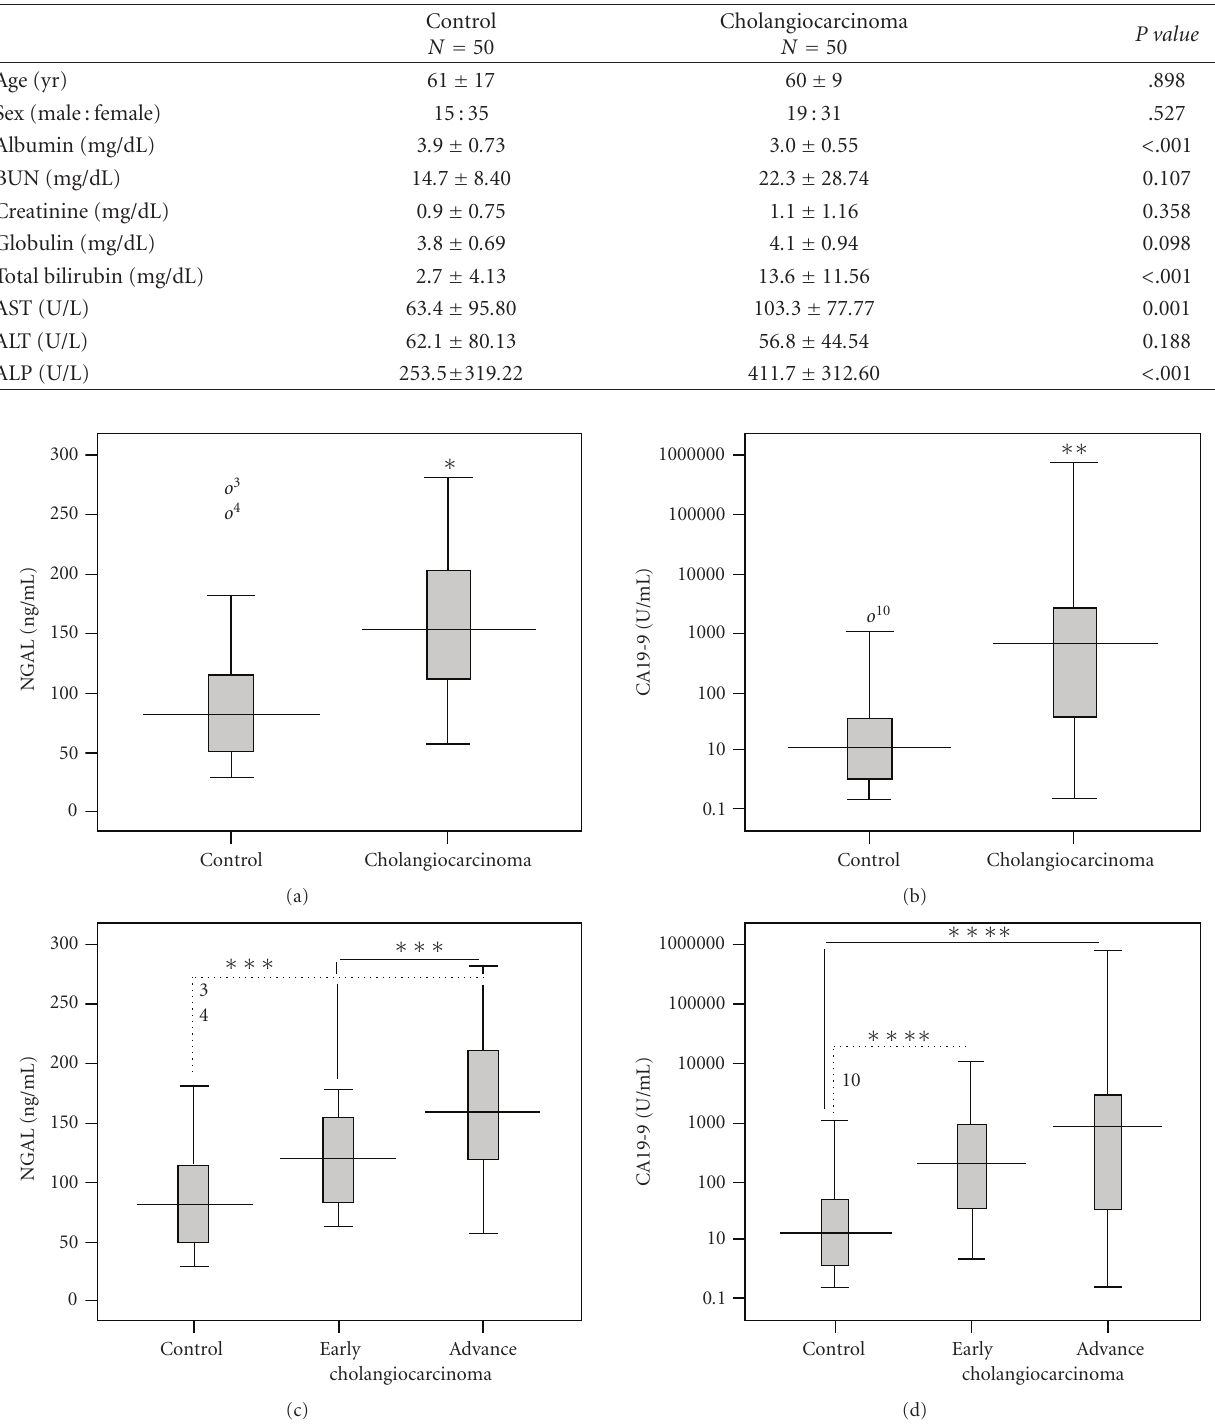
Table 1: Clinical characteristics of patients with benign biliary tract diseases (control) and cholangiocarcinoma. Control